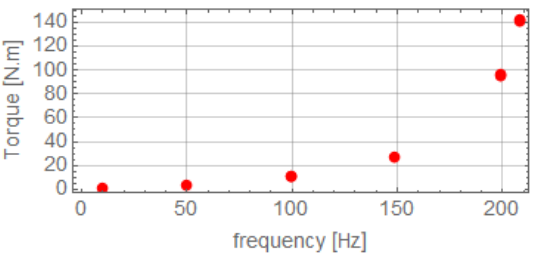
Figure . Amplitude of the torque as a function of frequency of